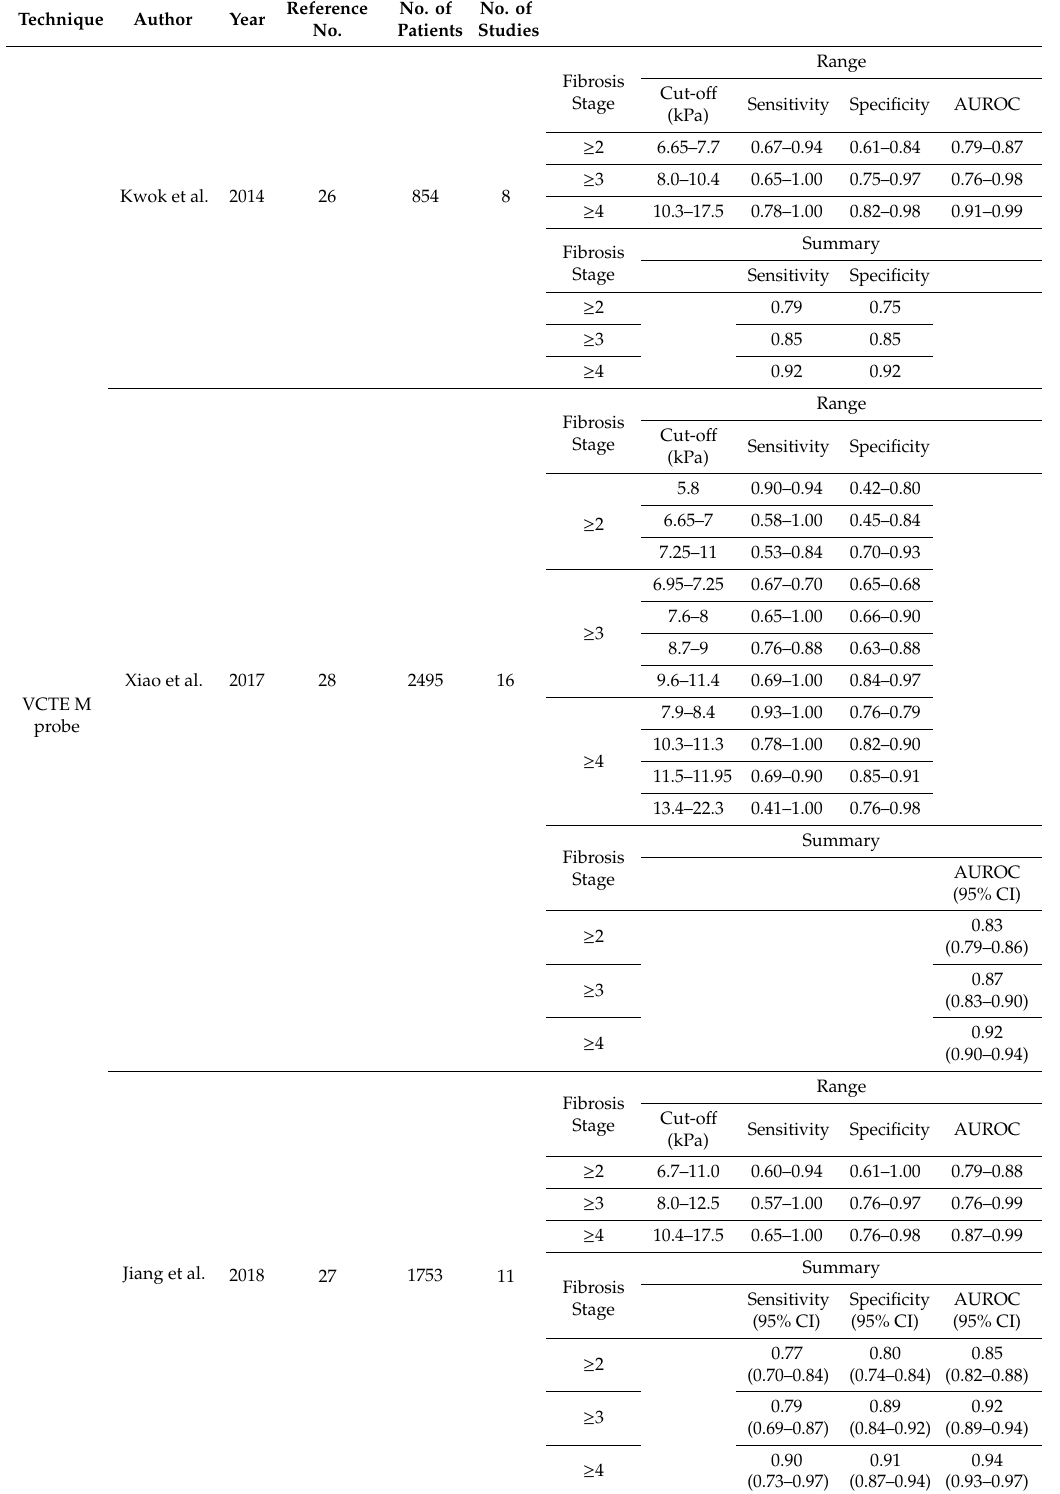
Table 1. Meta-analyses of elastography techniques for the diagnosis of liver fibrosis in patients with non-alcoholic fatty liver